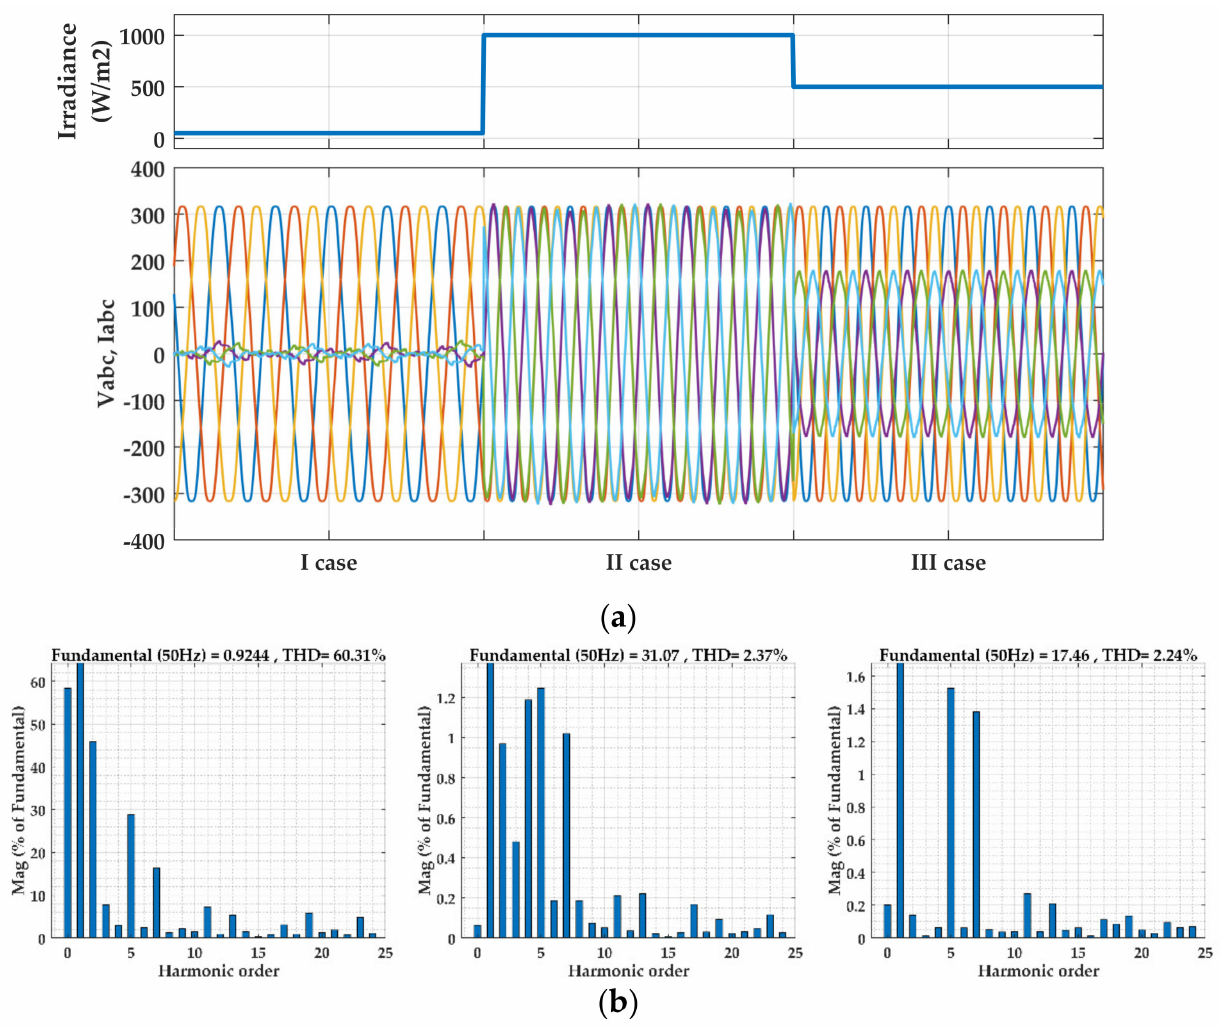
Figure 4. Simulation results: ( a ) Three phase voltages and currents depending on the irradiance level; ( b ) harmonic spectra and THD I for each level of